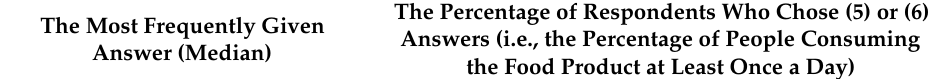
Table 5. The frequency of consumption of selected food products—(1) never or almost never, (2) once